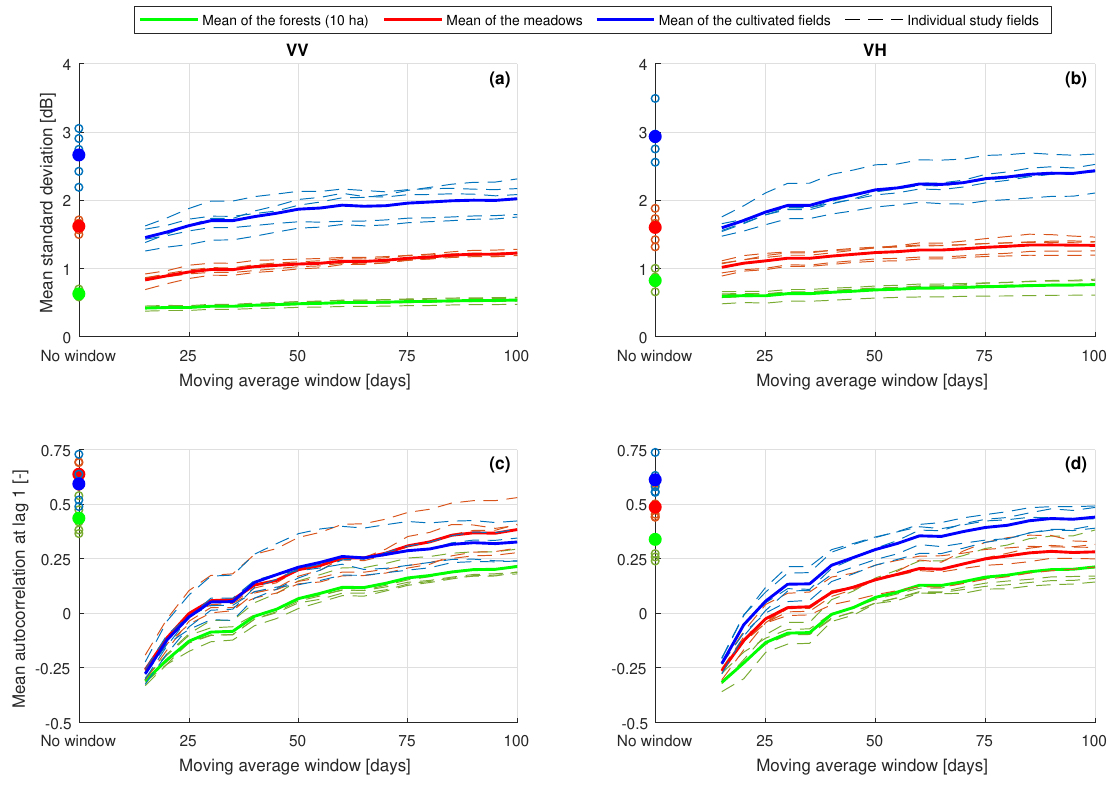
Figure 3. Standard deviation for the VV ( a ) and VH polarization ( b ) and autocorrelation at a lag of 1 for the VV ( c ) and VH polarization ( d ), averaged over all orbits, for the d σ 0 timeseries calculated with Equation (1) using a moving average window varying from 15 days to 100 days. The values labelled as ’no window’ were calculated for the anomalies of Sentinel-1 σ 0 observations with respect to the mean of the timeseries. The dashed lines represent the individual study fields and the solid lines are the means per land cover